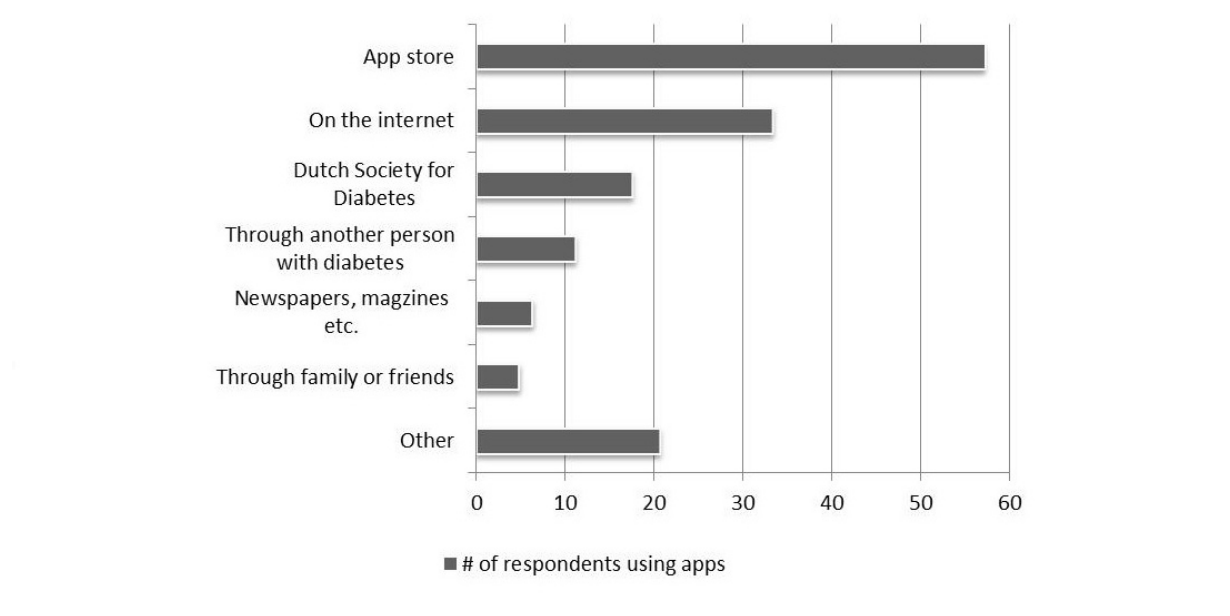
Figure 5. Popularity of different sources for obtaining aps. Data is presented as percentage of respondents using apps and that answered this question (n =63 out of 76 users). Multiple answers were